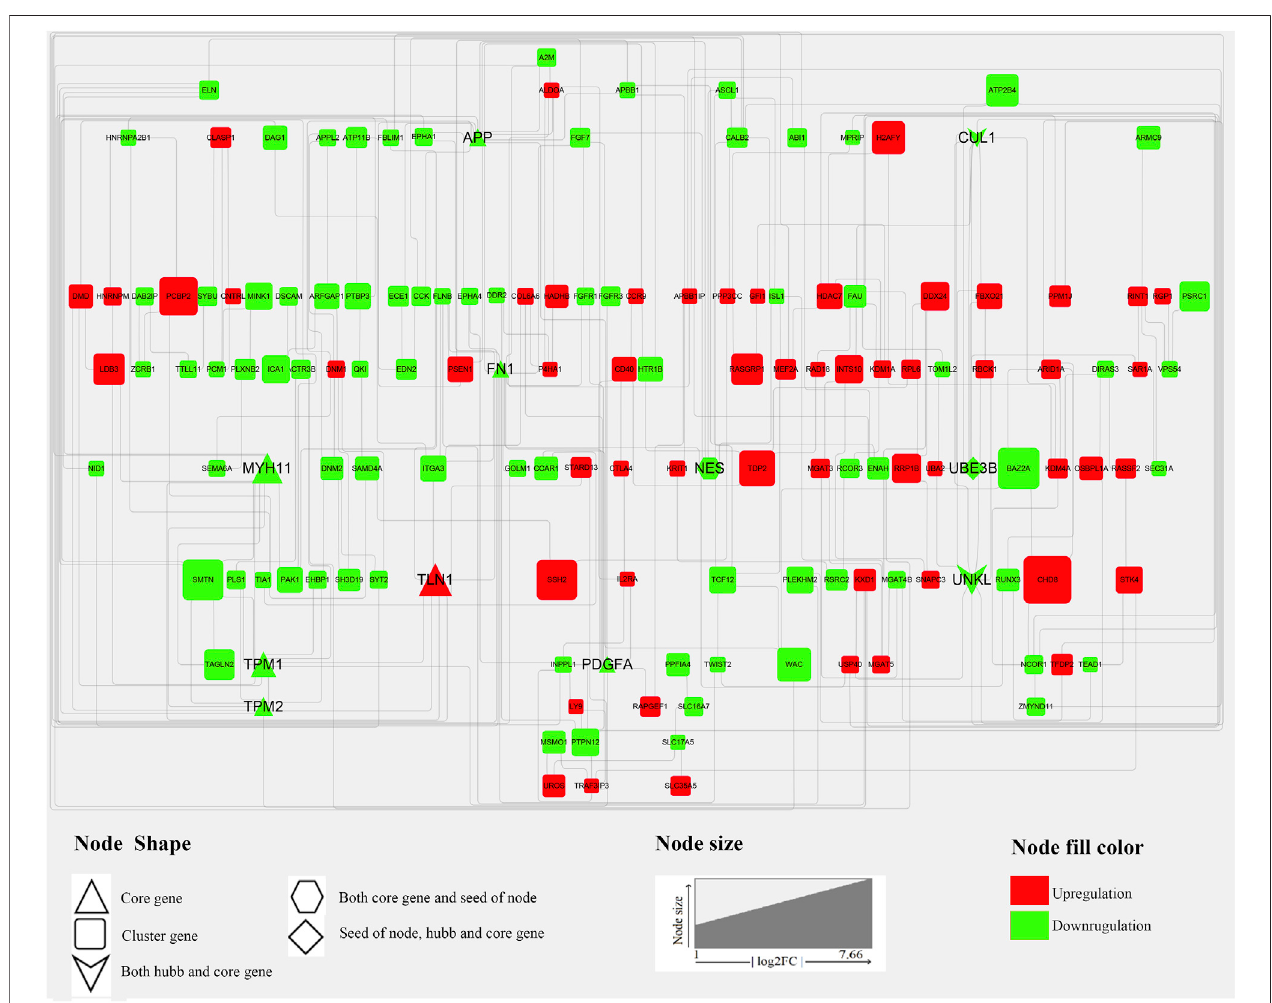
FIGURE 2 | PPI network of DEGs. In total, 235 nodes and 383 interaction associations were detected. The red and green nodes represent the up-and down- regulated genes, respectively. The shapes “ Triangles, ” “ hexagon, ” “ Square, ” “ diamond ” and “ V ” denote the “ Core gene, ” “ Both core gene and seed of node, ” “ Cluster gene, ” “ seed of node, hub, and core gene, ” and “ Both hub and core gene. ” The “ core genes ” represent the overlap of the top 20 genes obtained using Degree, DMNC, MCC, and MNC. “ hub genes ” represent those genes which calculated by analyzing tools in Cytoscape from the PPI network, and the “ seed of node ” are those at the seed nodes of modules 1 or 2. “ cluster genes ” represent members of the